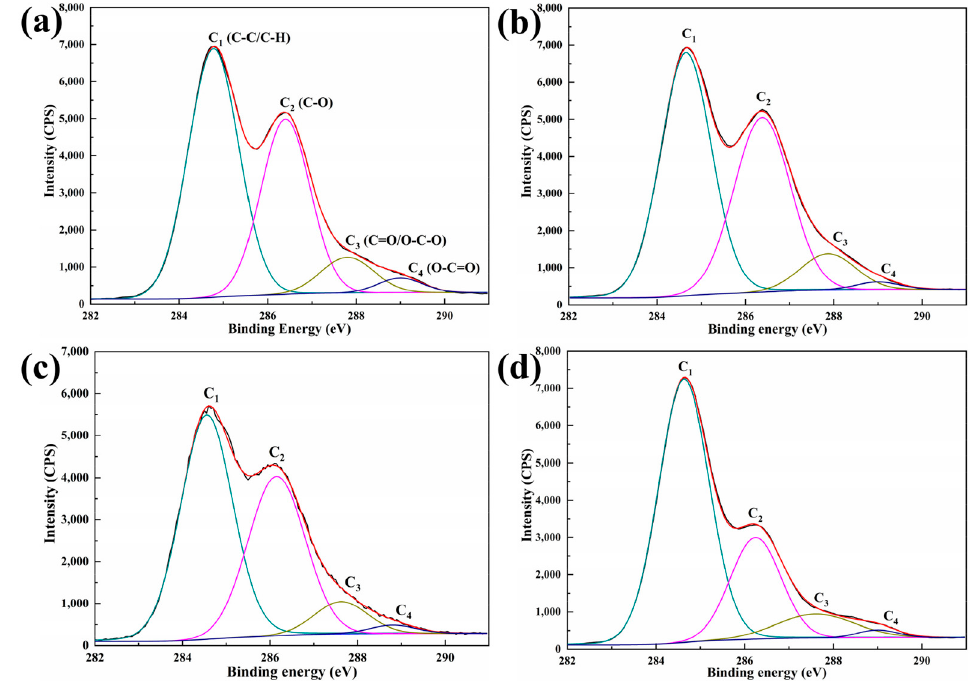
Figure 7. C1 s spectra of scrimbers with varying density: ( a ) 0.80, ( b ) 1.01, ( c ) 1.20 and ( d ) 1.39 g/cm 3 .